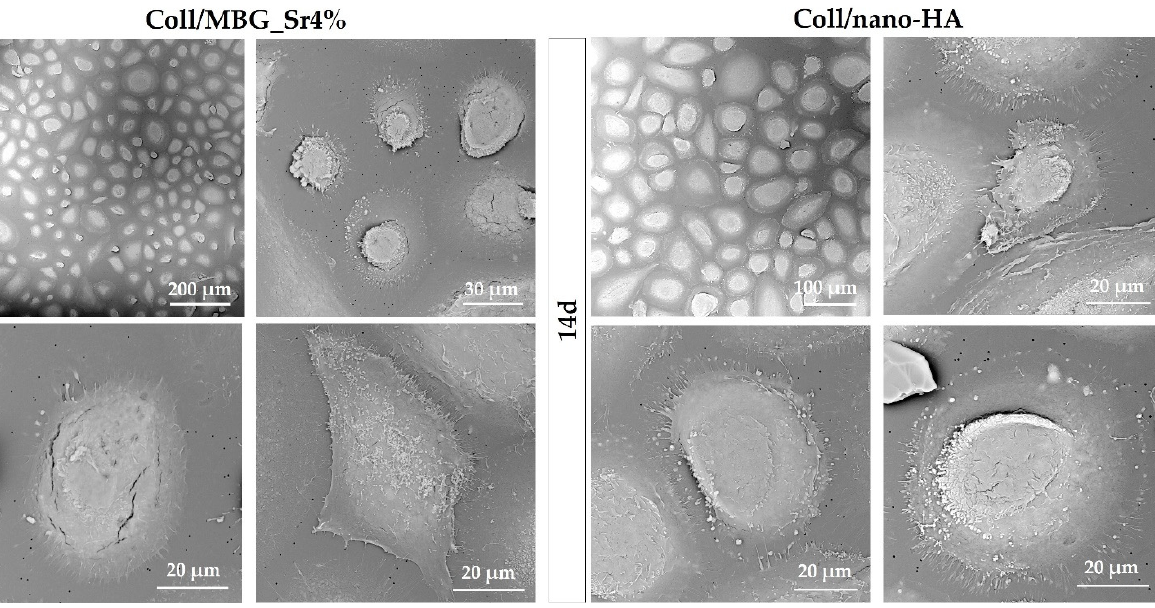
Figure 10. Diagram of the ALP activity at 7 and 14 days in the supernatant (surn) and cell lysate (lys) of OBs seeded on Coll/MBG_Sr4% and Coll/nano-HA in the indirect co-culture. ALP increased in the supernatants and cell lysates for both materials after 14 days, with the Coll/MBG_Sr4% sample showing the highest value for the cell lysate. 3.2.6. Assessment of Osteoclast Precursor Maturation The differentiation of PBMCs toward OC precursors (pre-OCs) in the indirect co-culture with OB-loaded materials was investigated by histochemical staining of actin and multinuclearity (Figure 11), as well as TRAP (Figure 12).